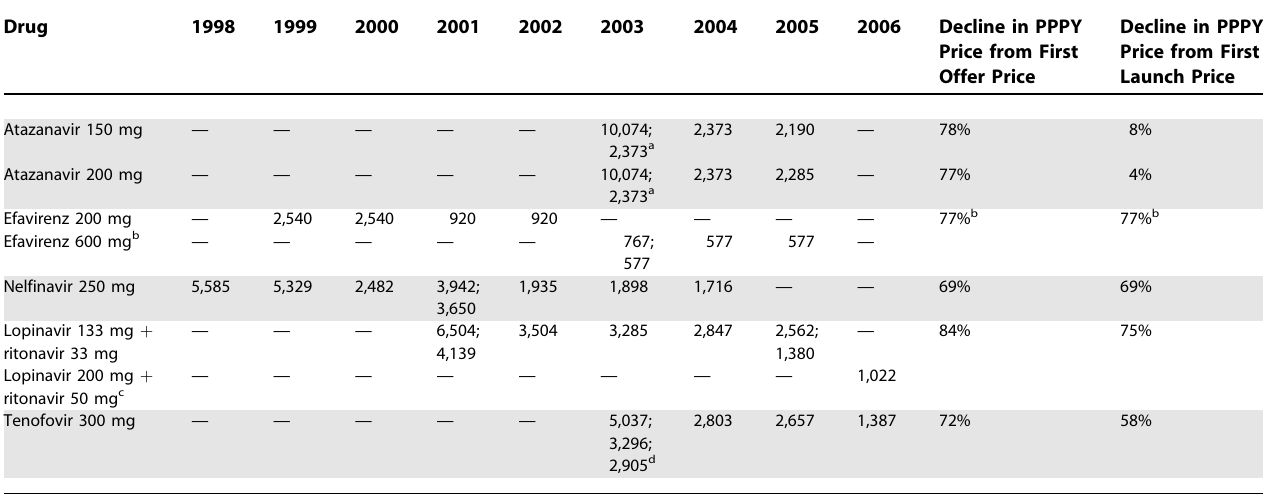
Table 2. Price Declines for Select Patented ARVs in Brazil, PPPY, US$